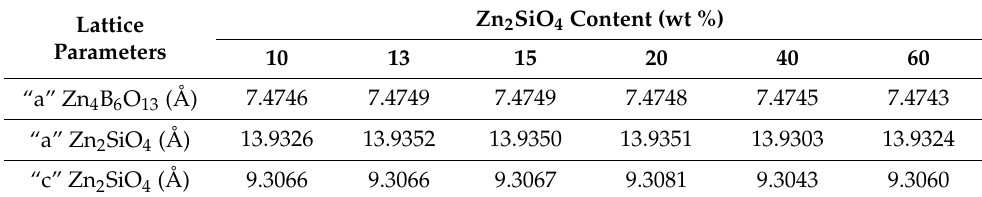
Table 1. Lattice parameters of Zn 4 B 6 O 13 –Zn 2 SiO 4 composites. Lattice